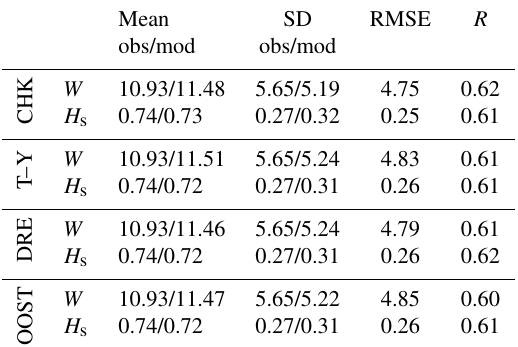
Table 3. Statistics for the comparison between buoy measurements and model outputs. W is the wind intensity (in ms − 1 ); H s is the significant waves height (in m). Statistics are only for the wind jet event (i.e. from 20 to 23 May